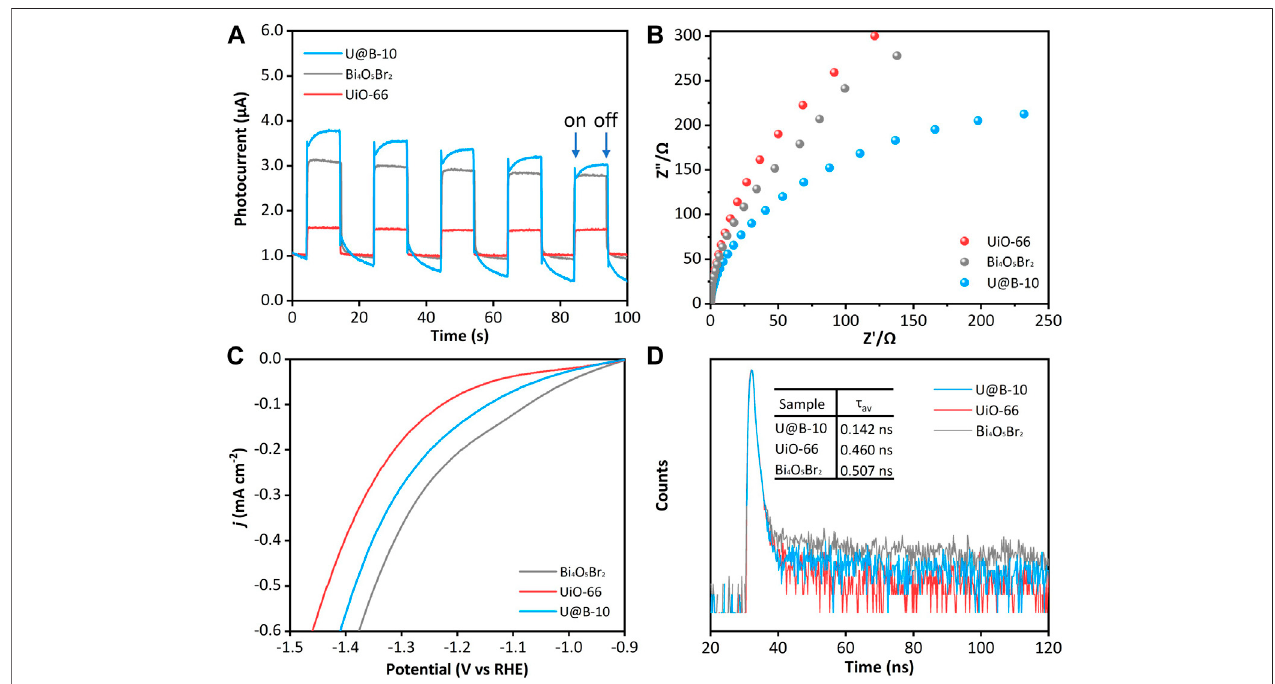
FIGURE 5 | (A) Transient photocurrent spectra, (B) EIS spectra, (C) LSV curves, (D) TRPL of Bi 4 O 5 Br 2 , and U@B-10.